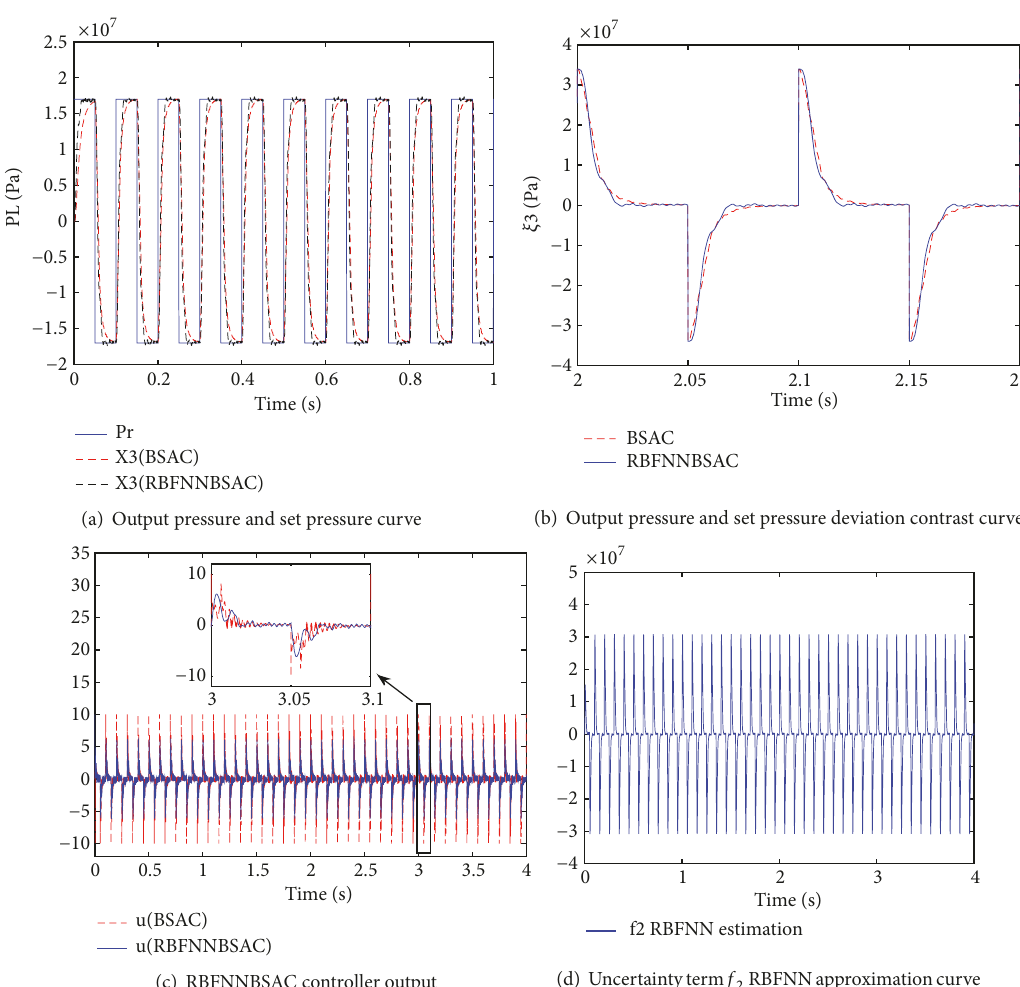
Figure 8: Performance curve of dynamic pressure cylinder AMESim model RBF neural network backstepping sliding mode adaptive control (10Hz square